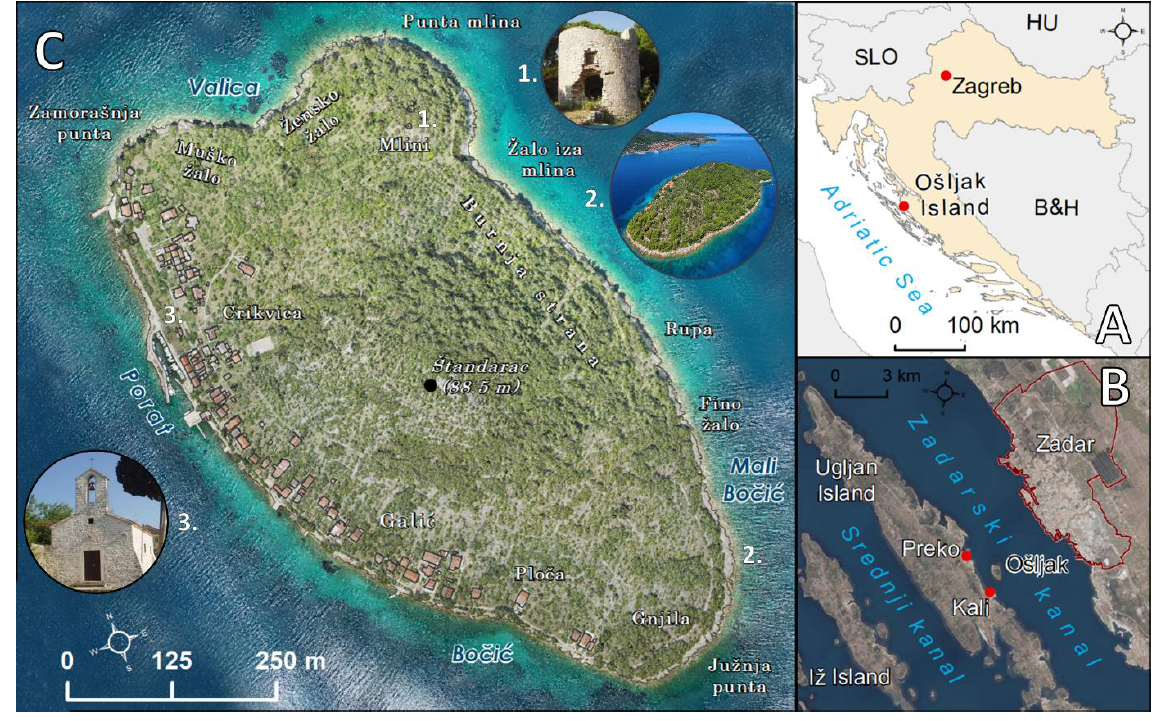
Figure 1. ( A ) The position of Ošljak in HR, ( B ) Zadar archipelago, and ( C ) Ošljak Island. Table 1. The number of Ošljak inhabitants in the period 1857–2021.